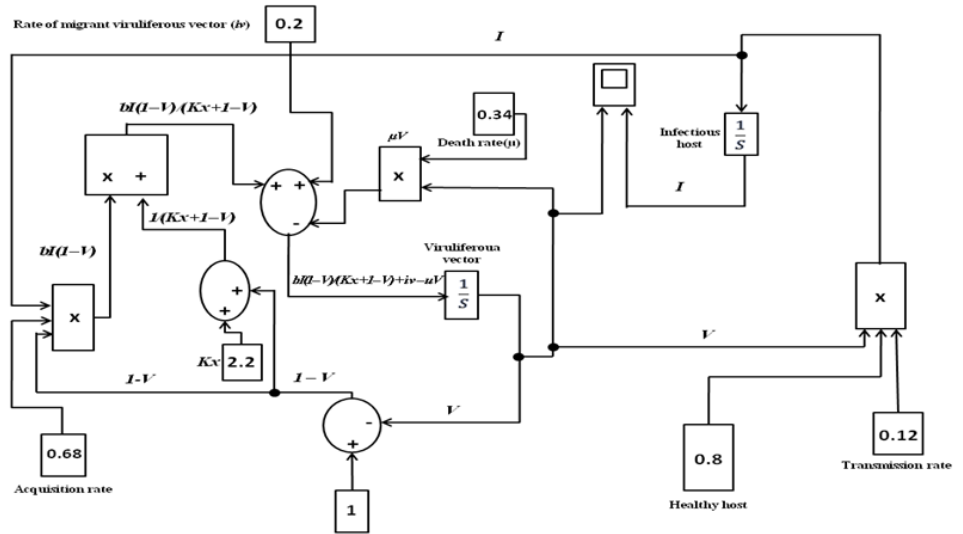
Figure 1. Simulink model for the prediction of leaf curl epidemic explained through the tripartite interactions of host–vector–virus transmission process in chilli.